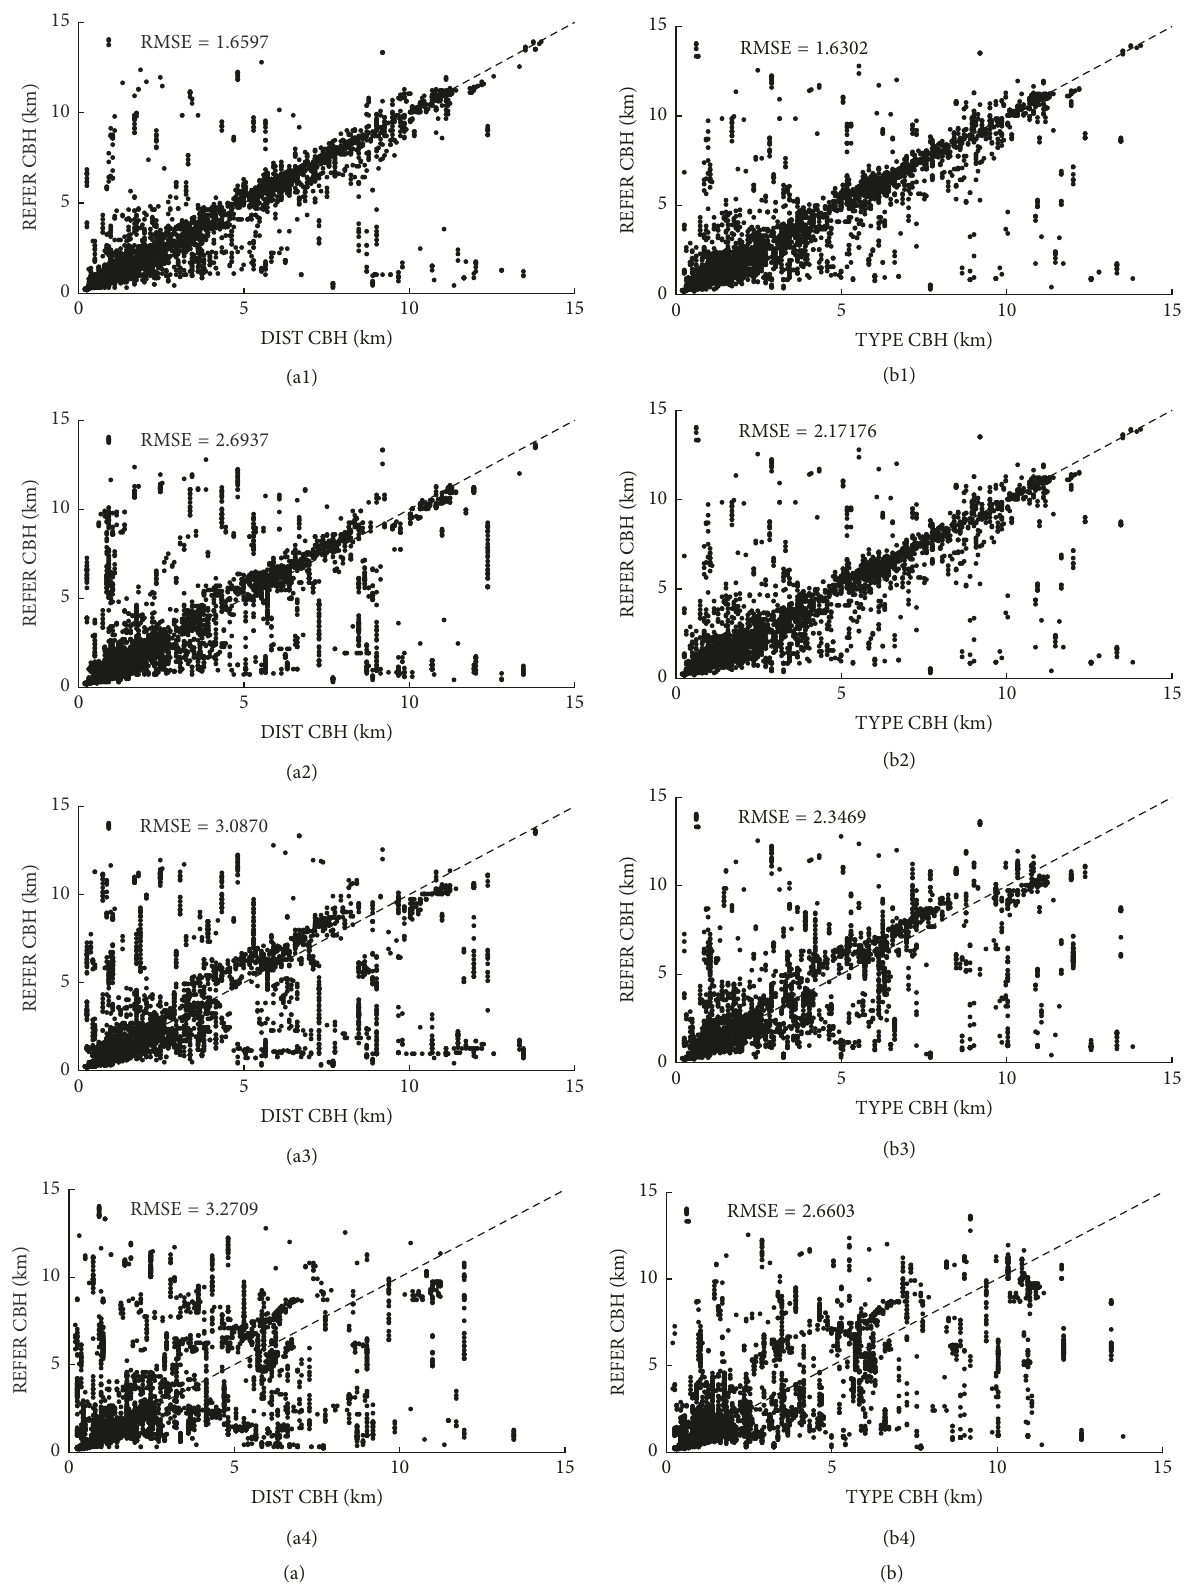
Figure 3: Comparison CBH estimation of DIST (a) and TYPE (b). 1, 2, 3, and 4 denote donor point distances of 10km, 50 km, 100 km, and 200 km,